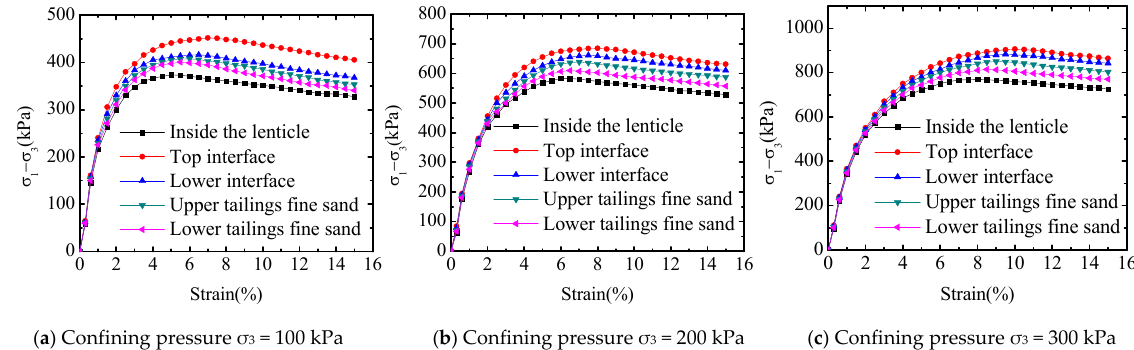
Figure 4. Deviatoric stress-strain curves of reinforced soil in different reinforcement positions, n = 1. ( a ) Confining pressure σ 3 = 100 kPa, ( b ) Confining pressure σ 3 = 200 kPa, ( c ) Confining pressure σ 3 = 300 kPa.